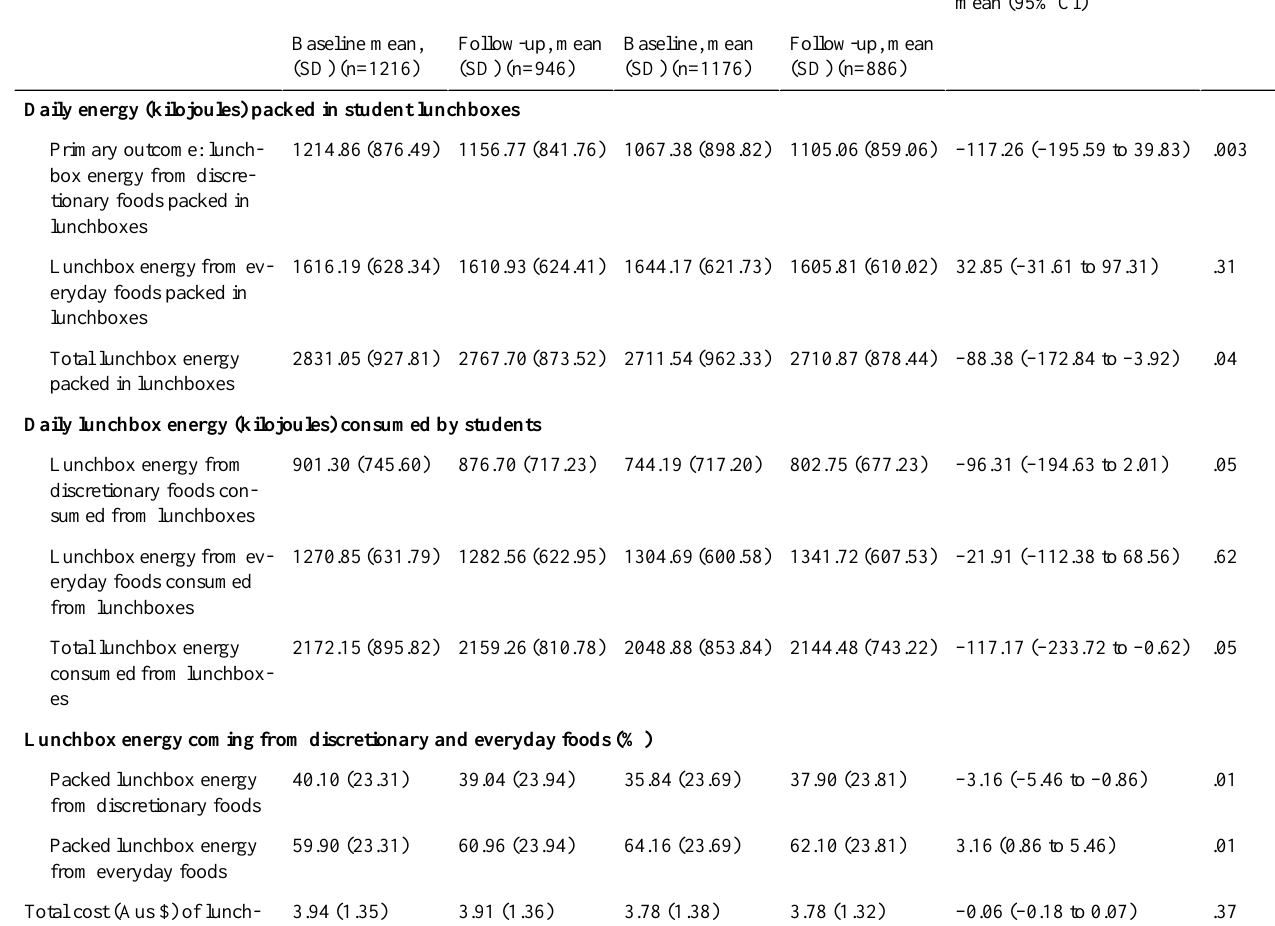
P valueDifference in energy be-